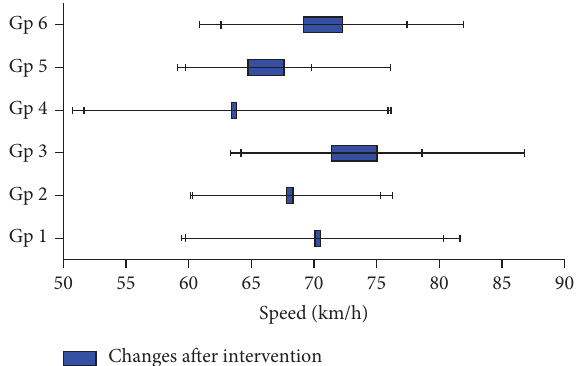
Figure 5: Changes in the mean speed in the 80km/h zone after the intervention (the error bars represent the standard variance).